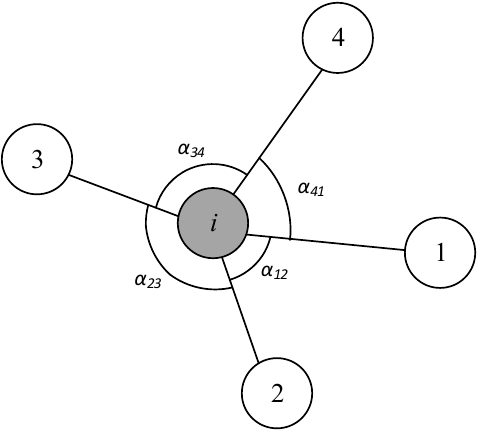
Figure 2. Angles between two adjacent neighbors in a five ‐ tree group.